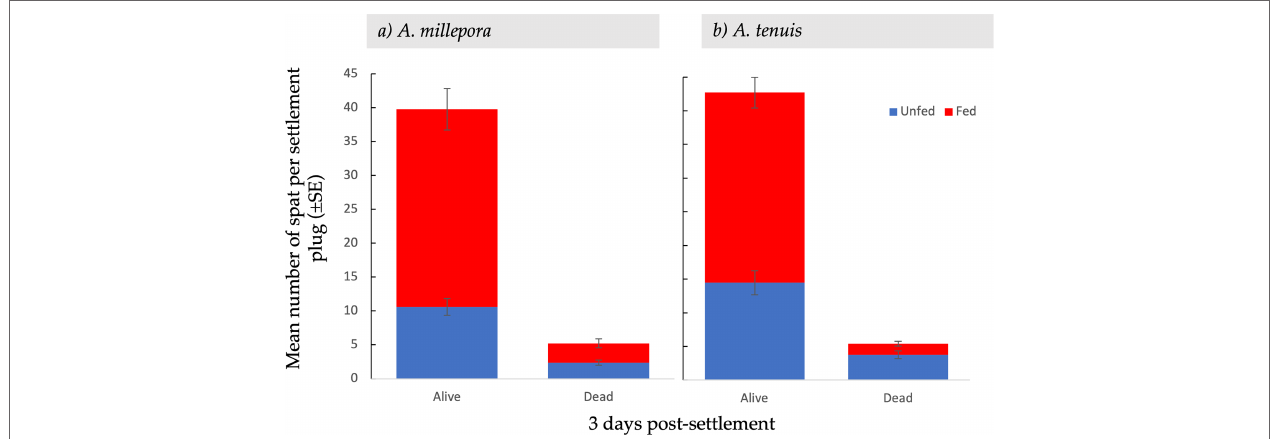
FIGURE 3 | Mean settlement ( ± SE) of alive and dead Acropora millepora (A) and Acropora tenuis spat (B) , from unfed and fed treatments, three days after the introduction of settlement cues.